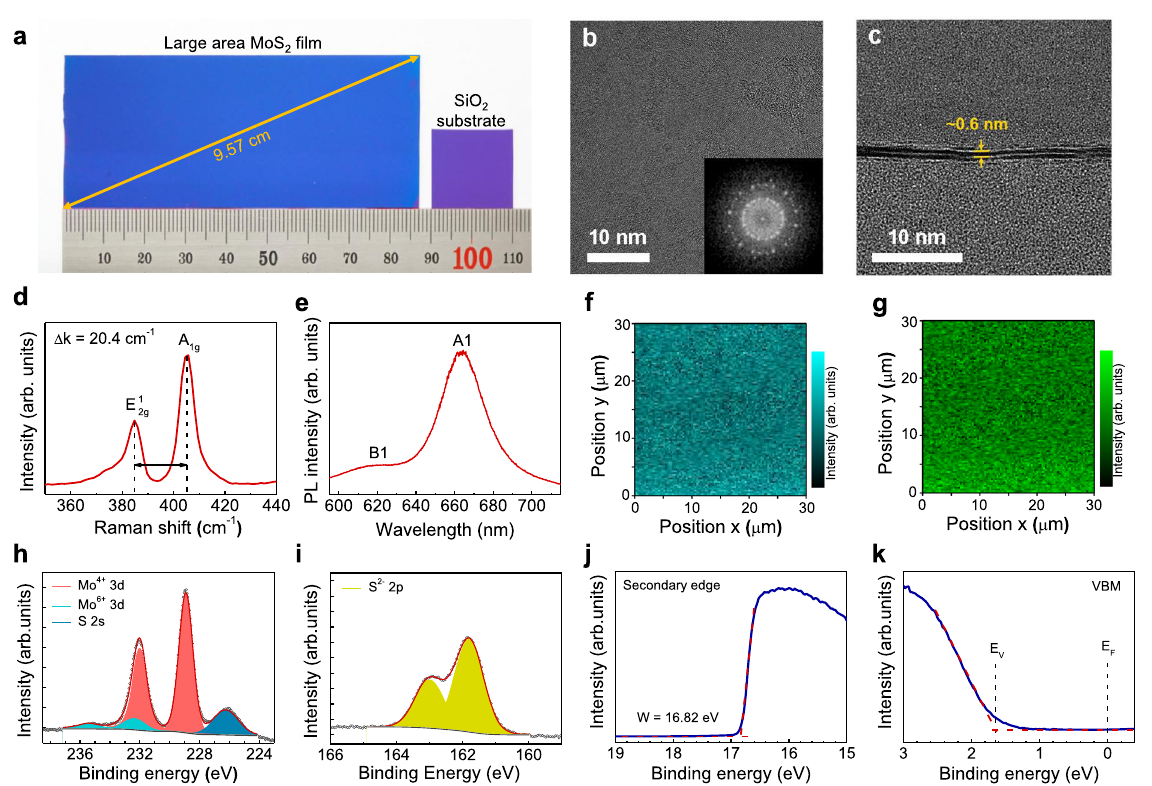
Fig. 3 Characterization of large-area bilayer MoS 2 fi lm. a Photograph of a synthesized bilayer MoS 2 fi lm on SiO 2 /Si substrate (blue) comparison with a bare SiO 2 /Si substrate (purple), indicating the color changes for before and after MoS 2 growth. b Plan-view and c cross-sectional TEM images of the bilayer MoS 2 fi lm. The inset of b is a FFT pattern corresponding to the TEM image. d Raman and e PL spectrum of the bilayer MoS 2 fi lm. f , g Raman mapping images of the intensity of E 1 2g and A 1g modes centered at 383 and 404 cm − 1 , respectively. h , i XPS spectra of Mo 3 d and S 2 p core levels of the bilayer MoS 2 fi lm, respectively. j Secondary cut-off and k valence band spectra obtained by UPS analysis of bilayer MoS 2 fi